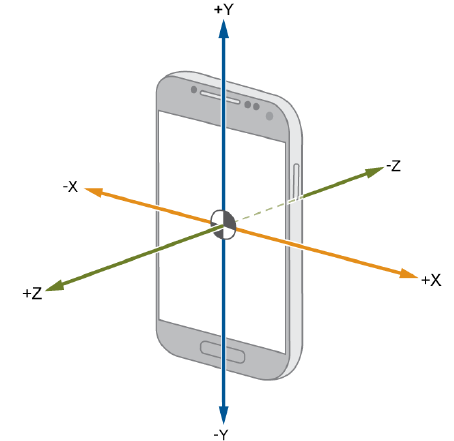
Figure 2. Coordinate system smartphone [13].